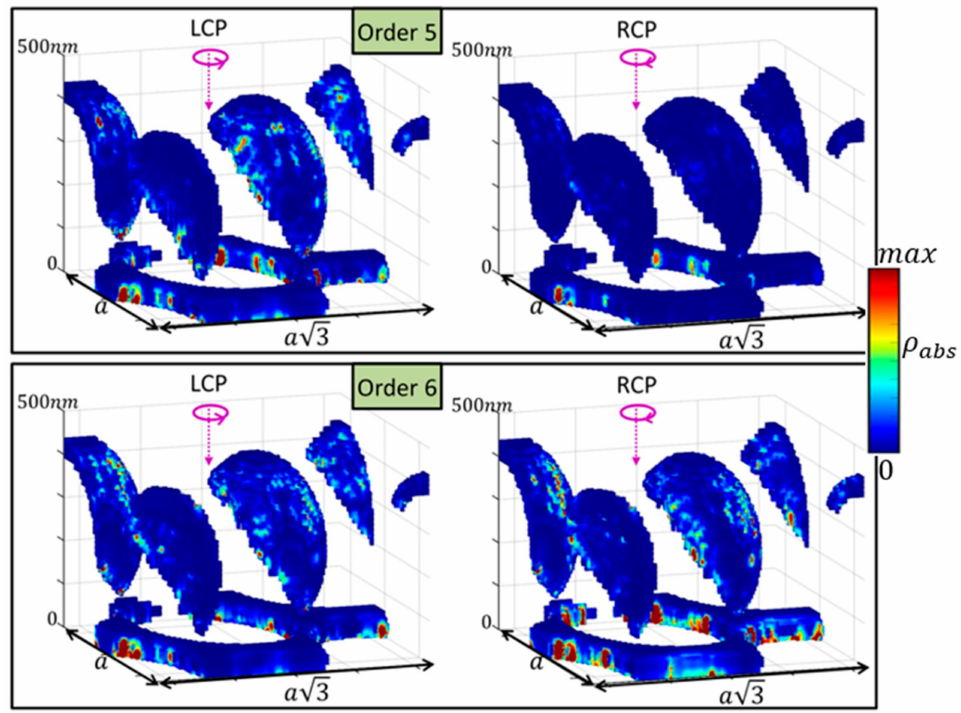
Figure 7. Distribution of the absorbed power in the unit cell when the metasurface is excited with LCP or RCP wavelength at 514 nm; absorption for orders 5 and 6 shown in the top and bottom panels, respectively, while the color scale is kept